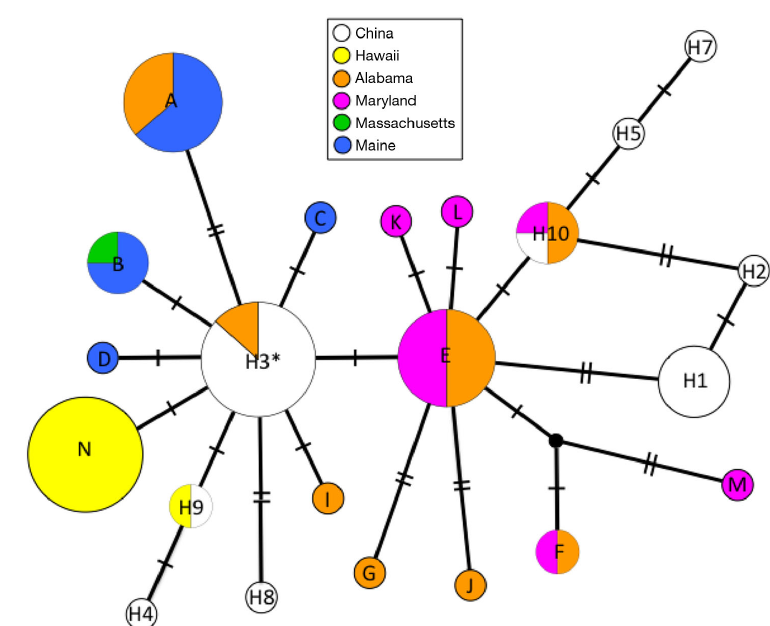
Fig. 3. We constructed a 95% maximum parsimony network for all 22 Polydora websteri mtCOI haplotypes included in this study. In this network, haplotypes are represented as circles with the size of each circle indicating the abundance of each haplotype in our dataset and the fill of each circle indicating the sam- pling sites where that haplotype was observed. In addition, lines along each connection between haplotypes indicate the number of mutations separating haplotype pairs. This analysis also indicated that haplotype H3 (asterisk) was the most probable outgroup